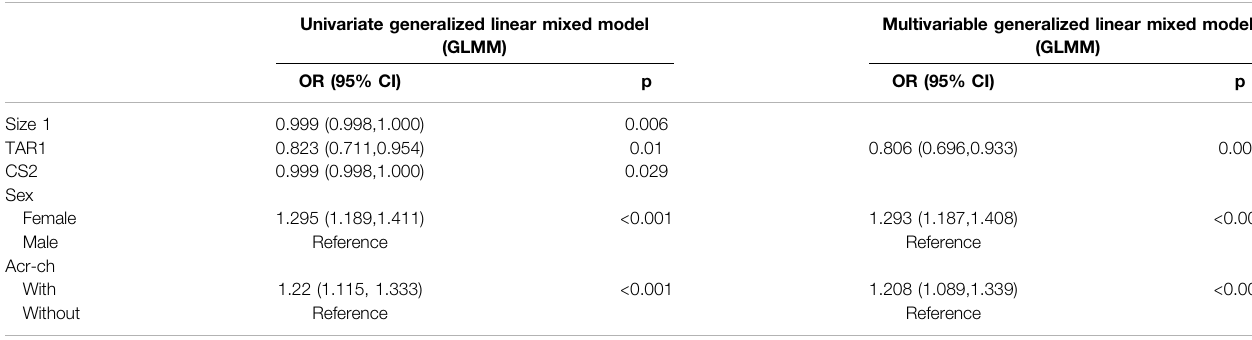
TABLE 2 | Univariable and multivariable generalized linear mixed model analysis for unbalanced